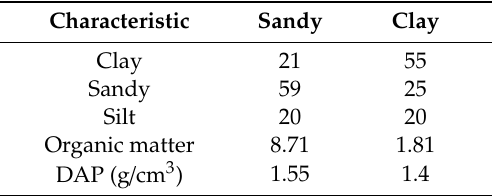
Table 1. Physical characteristics of soils used in the study.